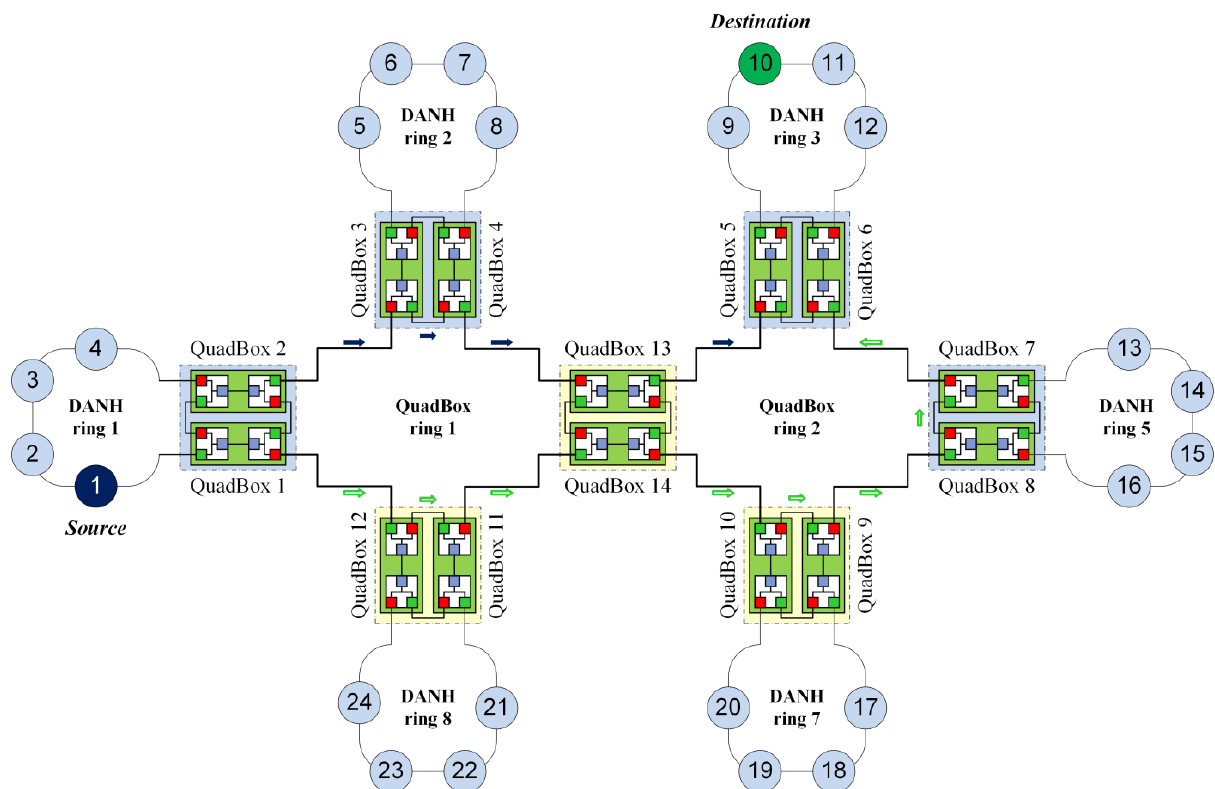
Figure 16. Forwarding unicast traffic under the RDP